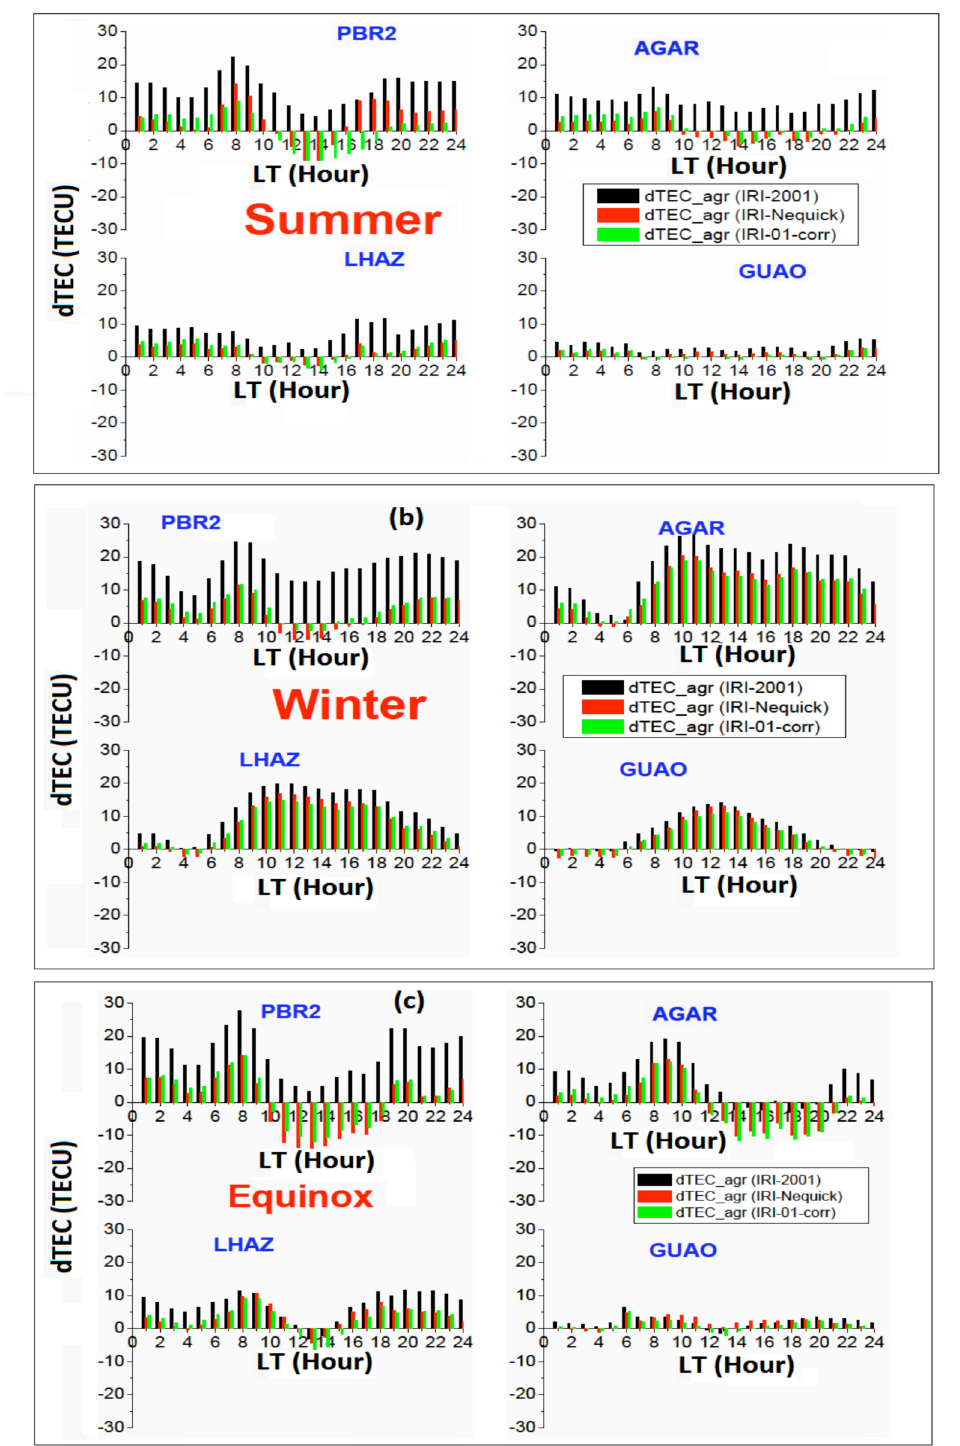
Figure 8. dTEC (IRI TEC - GPS TEC) variation for four stations during (a) summer (b) winter (c)